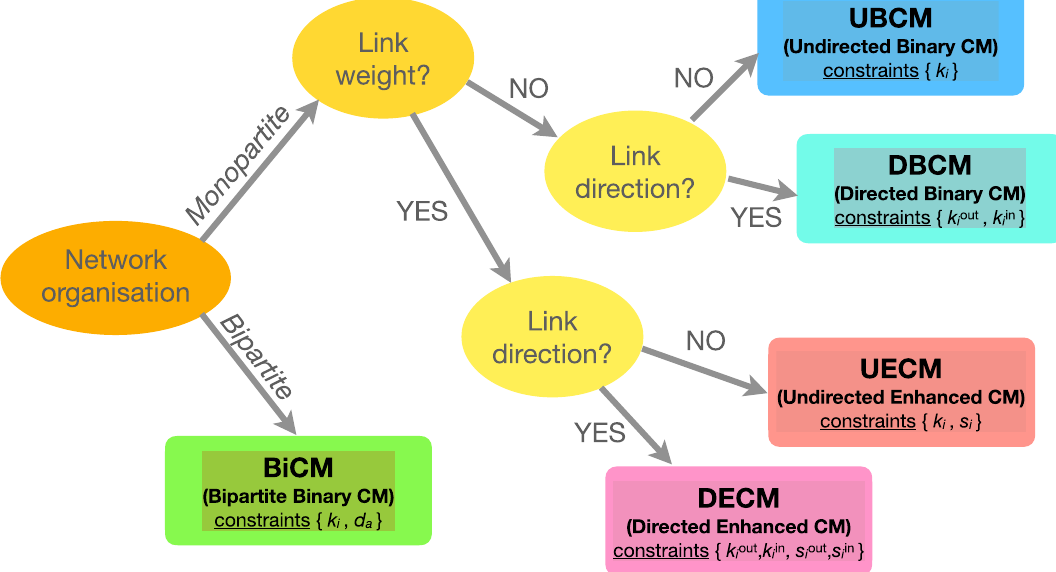
Figure 2. System diagram illustrating the models discussed in the present paper and implemented in the ‘NEMTROPY’ package, attached to it: it represents a sort of guide to individuate the best model for analysing the system at hand. Our package handles both monopartite and bipartite networks; while the latter ones have been considered only in their binary, undirected fashion, the former ones can be modeled either in a binary or a weighted fashion, allowing for both undirected and directed